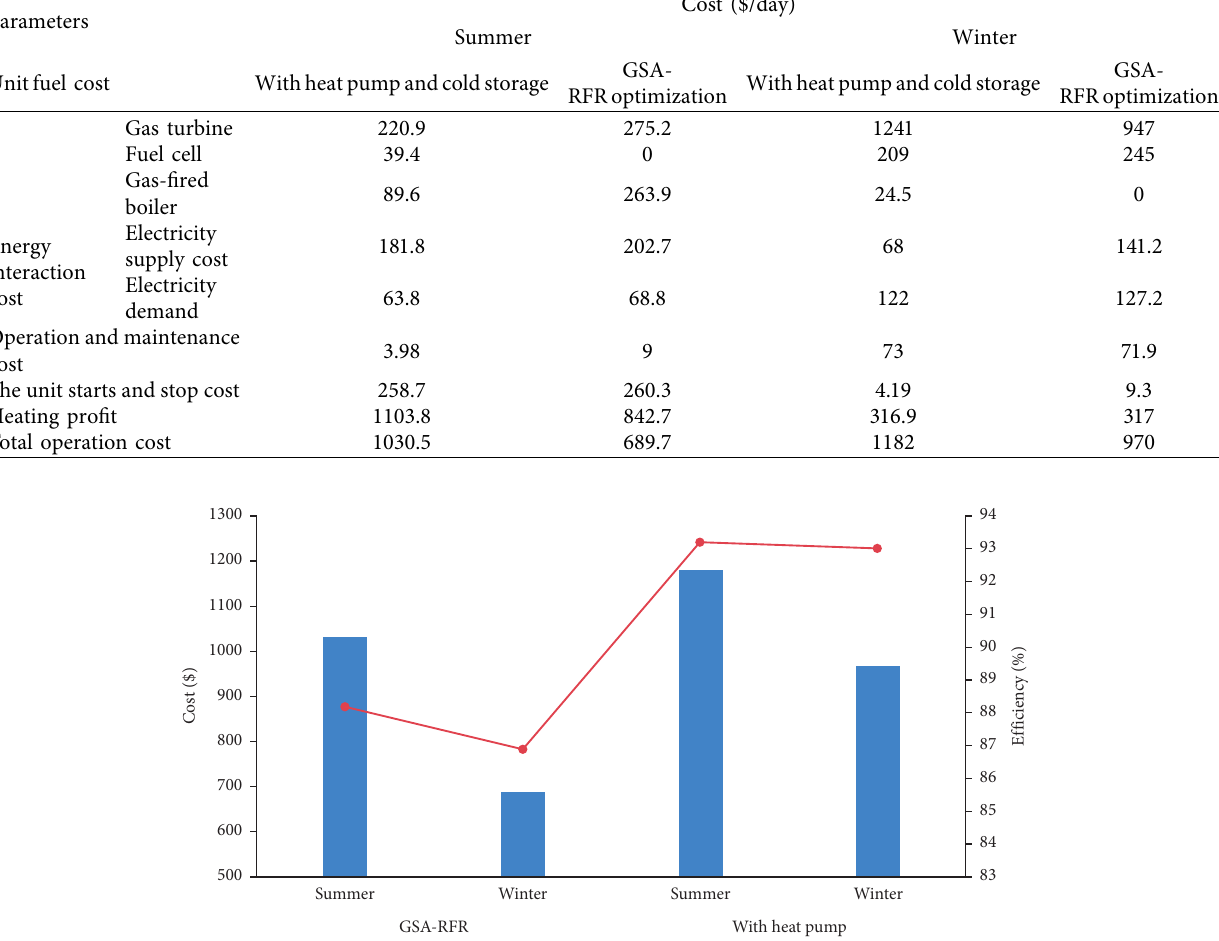
Table 5: Costs of the MG parameter under the two scheduling methods.